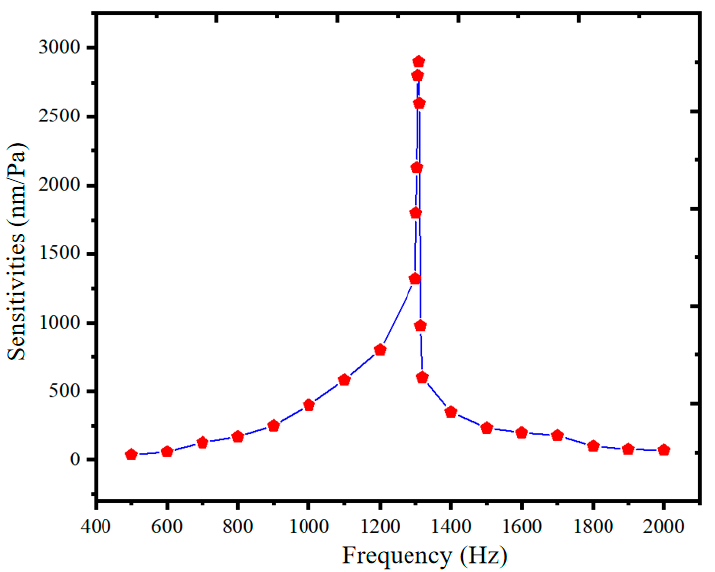
Figure 2. Frequency response of the cantilever-based acoustic sensor.